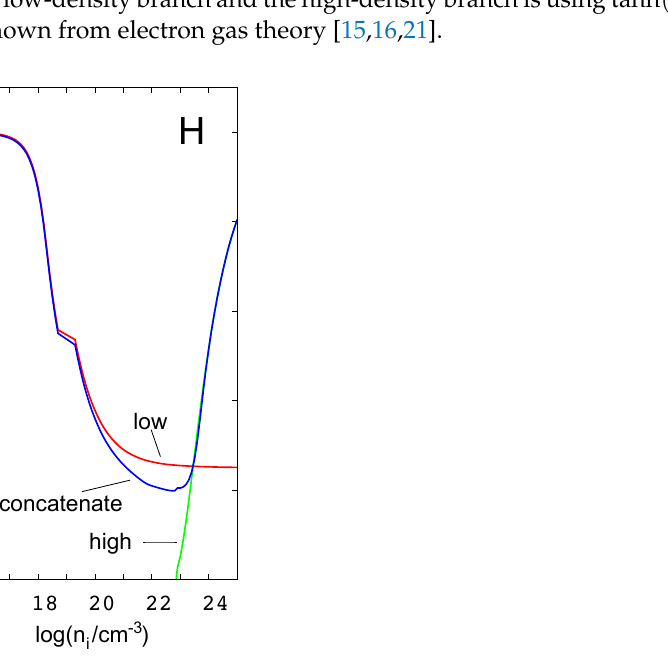
Figure 6. Hydrogen plasmas: We demonstrate the method of smooth concatenation for a hydrogen plasma at T = 20,000 K. After identifying a crossing point near to n i (cid:39) 10 23 cm − 3 we construct a smooth concatenation of the branches on the left (red) and right (green) sides of the intersection of the low-density branch (red) with the high-density branch (green). The blue curve shows the result of the concatenation using complementary tanh-functions ( a (cid:39) 1; y = n e Λ 3 e